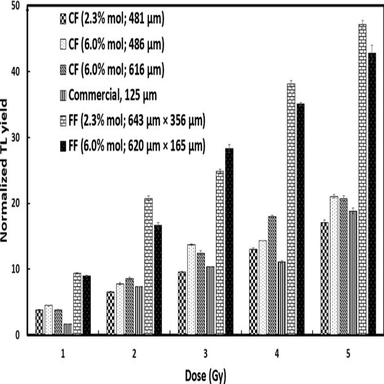
The sensitivity of FGDOFs and commercial optical fibres for 9 MeV electrons.